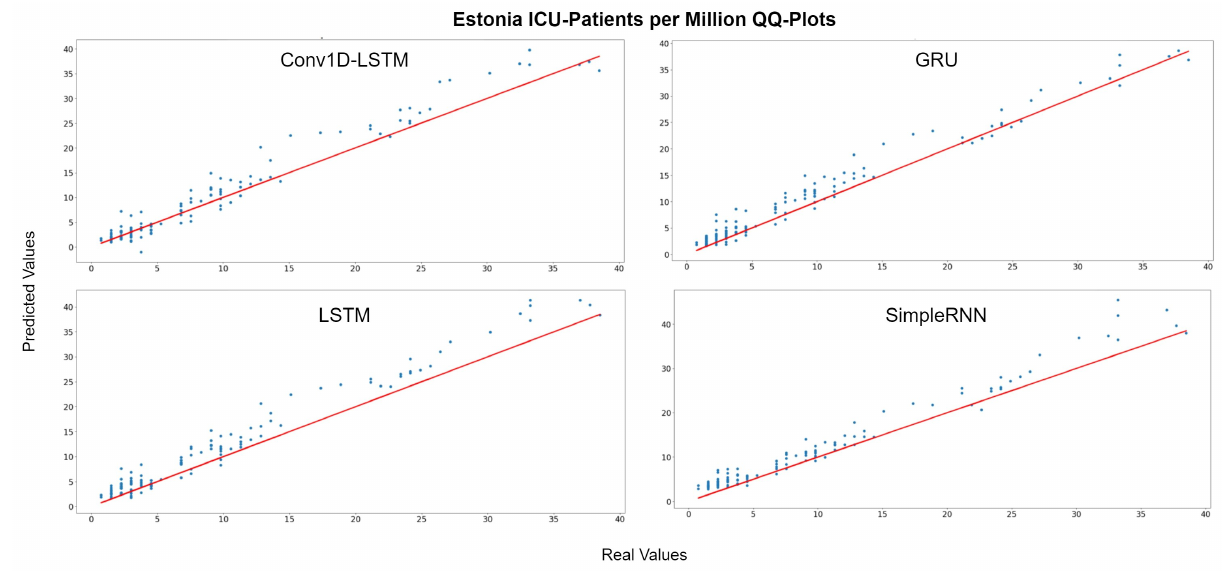
Figure 15. Estonia ICU-Patients per million QQ-Plot for each method.